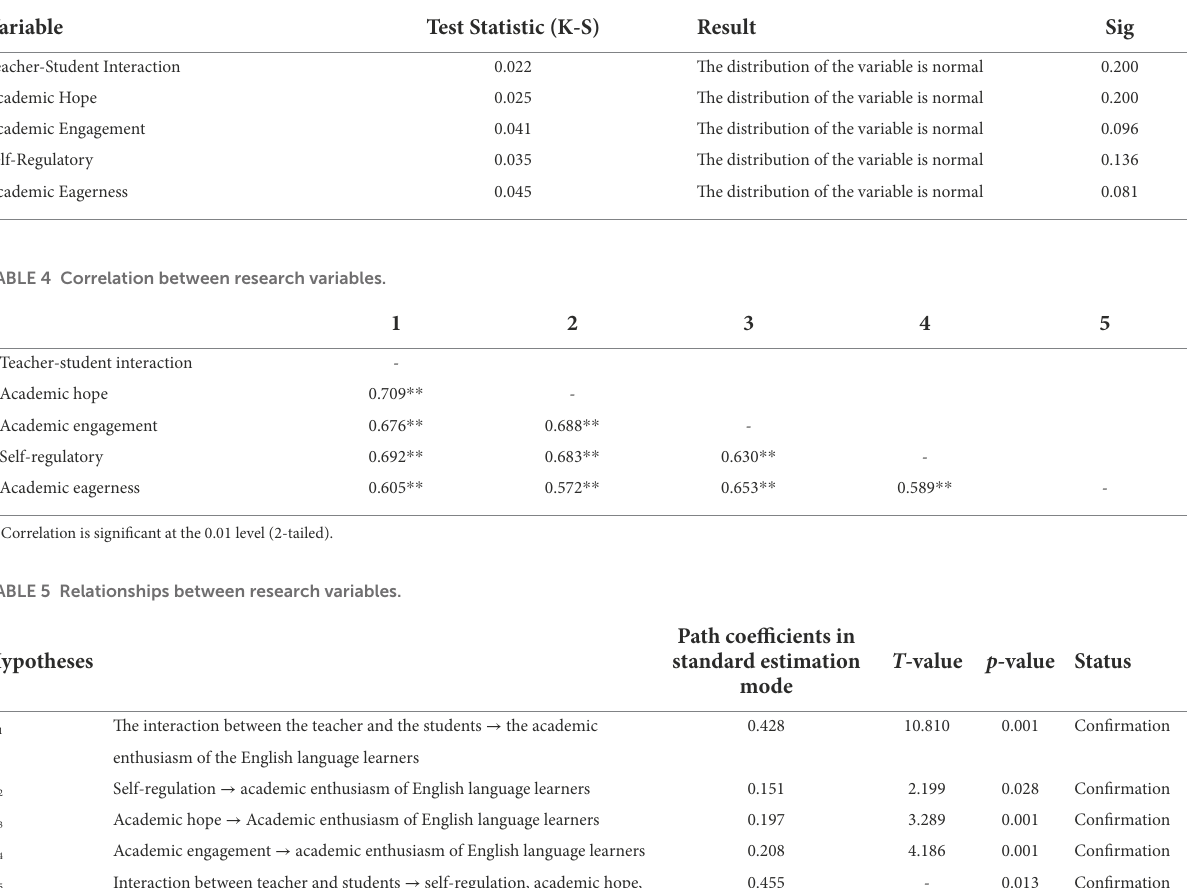
TABLE 3 Evaluation of normality of variables by Kolmogorov–Smirnov test.